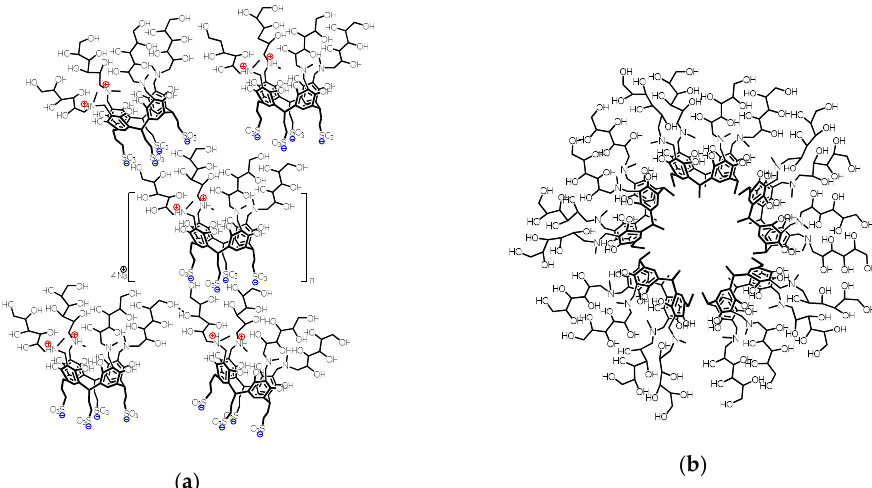
Figure 6. Proposed self-assembly structures of GCR-1 ( a ) and GCR-2 ( b ) formed in aqueous solutions.